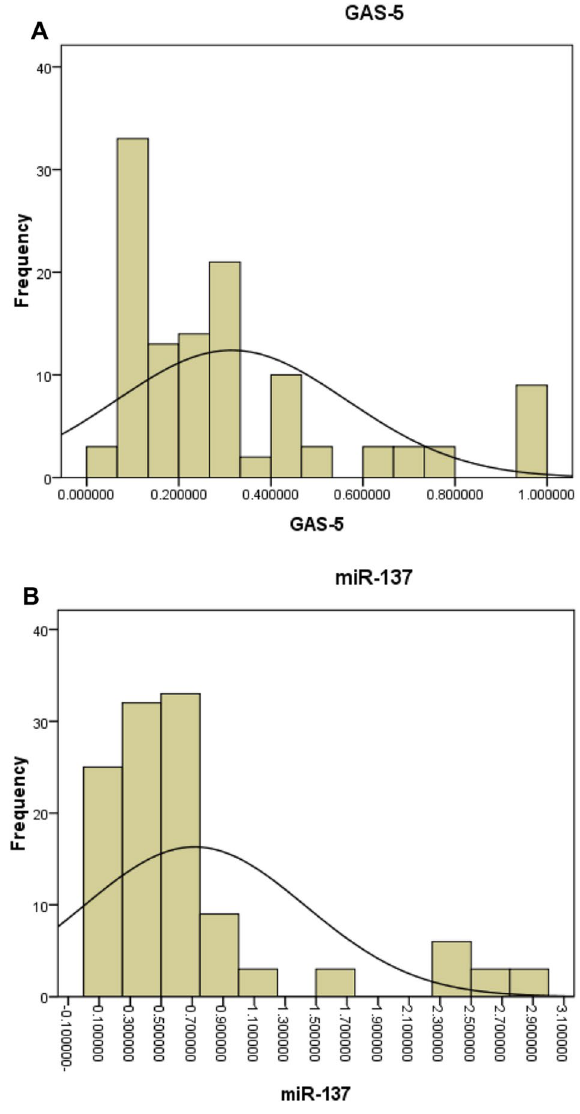
Figure 1. A frequency curve represents the serum expression levels (expressed as fold changes) of: (a) lncRNA growth arrest-specific 5 (GAS5), (b) miR-137; among chronic HBV cases Expression level among control subjects was considered as